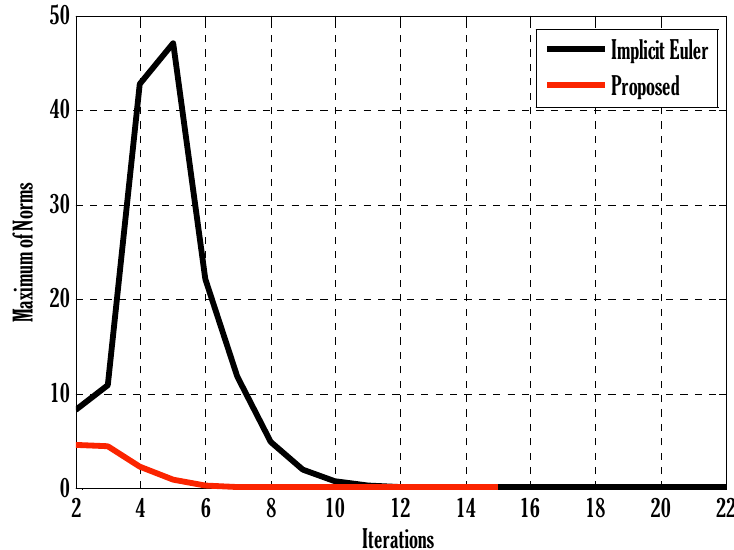
Figure 1. Convergence of two schemes using N = 30, β = 30, λ = 0.1, F r = 0.01, M = 0.3, E 1 = 0.01, E c = 0.01, N t = 0.1, N b = 0.1, Bi = 0.05, P r = 1.7, R d = 0.1, S c = 1.5, γ = 0.1, and L = 3.